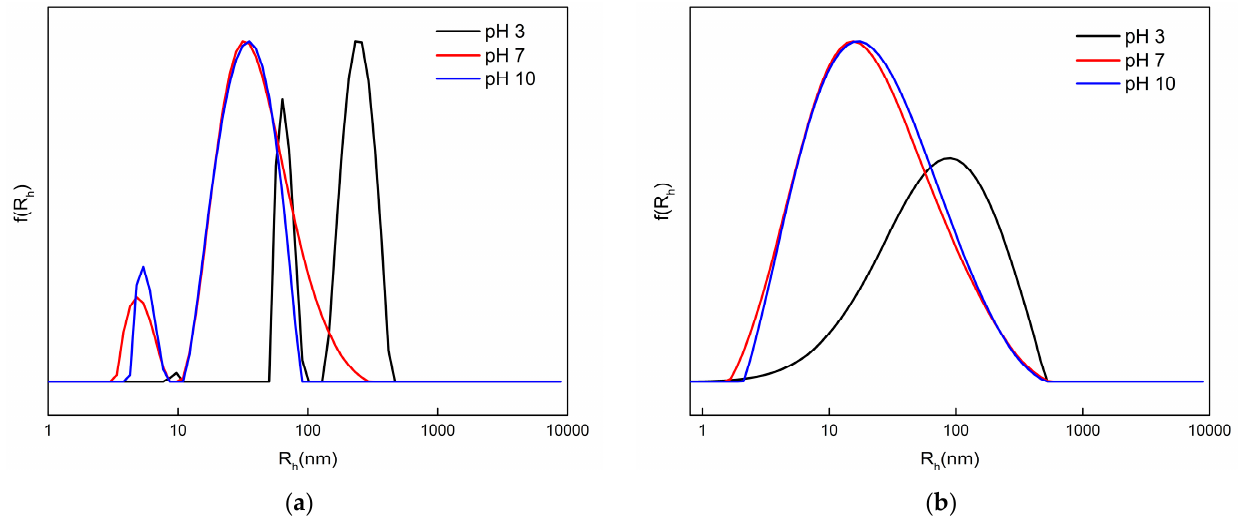
Figure 5. Size distributions from DLS analysis of HC 1 ( a ) and HC 2 ( b ) copolymers in aqueous media in varying pH solutions. Table 2. DLS and ELS results for HCs in aqueous media in varying pH solutions.